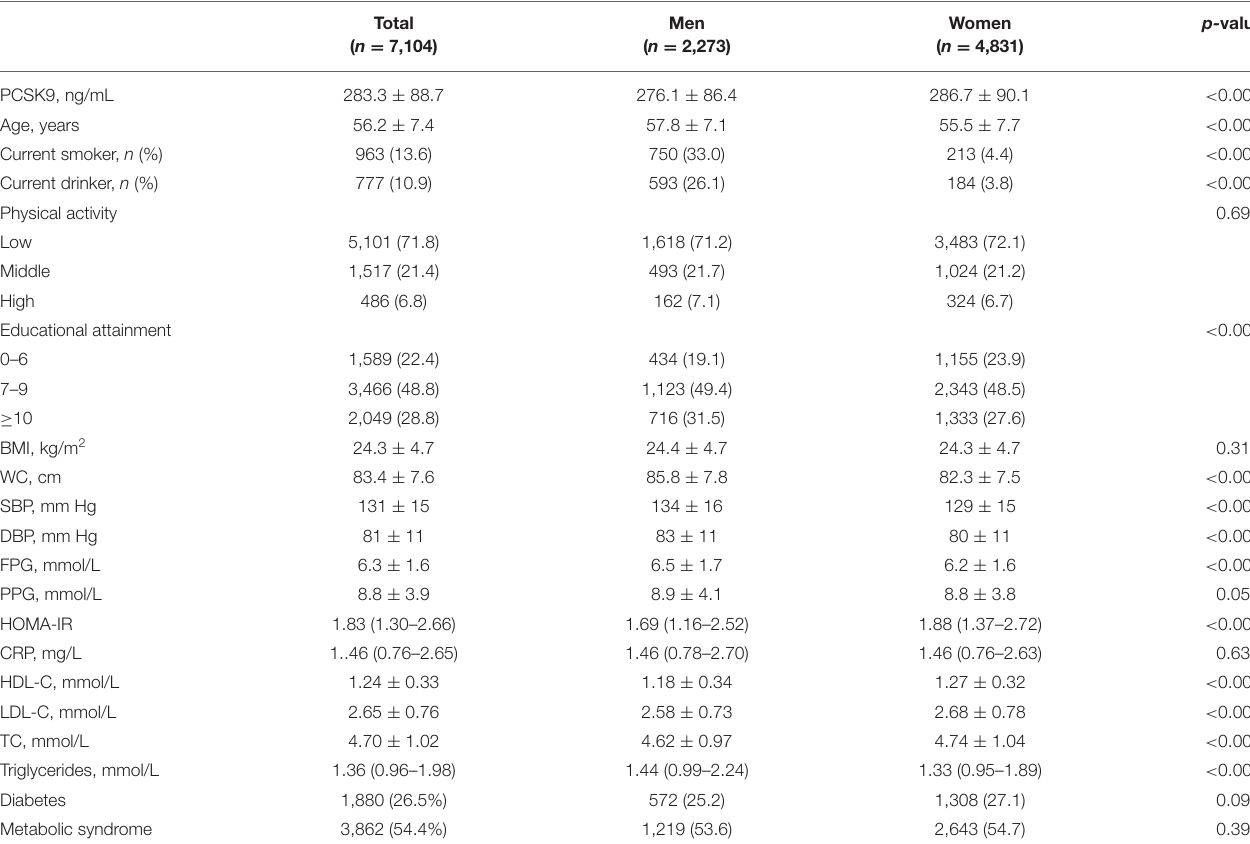
TABLE 1 | Baseline characteristics of the study participants ( n = 7,104).